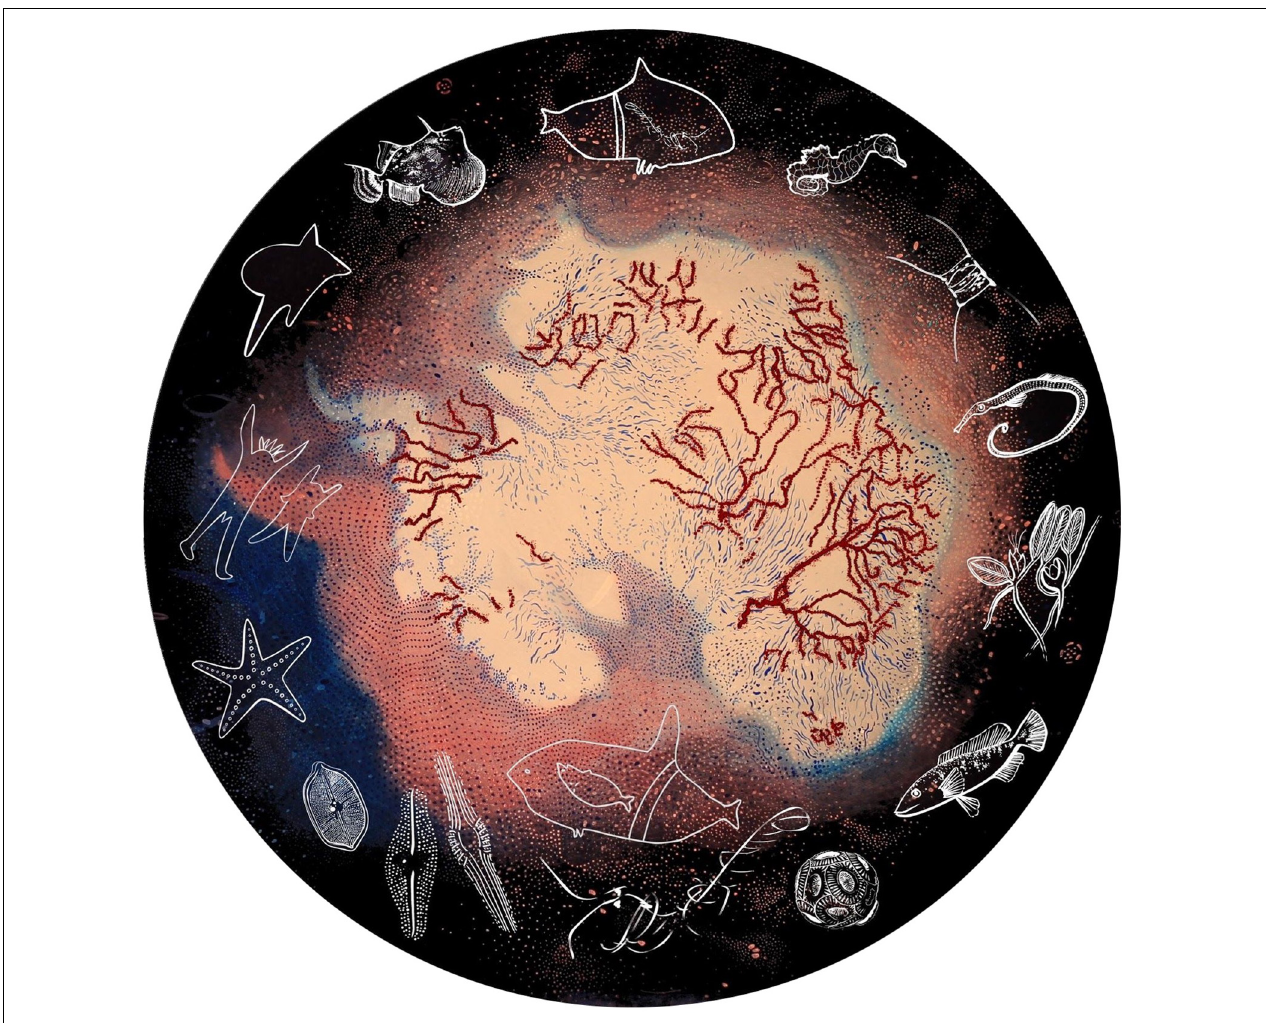
FIGURE 1 | Artwork signifies origins of this project in bringing together Australian Aboriginal perspectives and scientific data from Antarctica and the Southern Ocean. This illustrates pattern-matching between the Australian river catchments on the ice catchments and glacial flows of Antarctica.